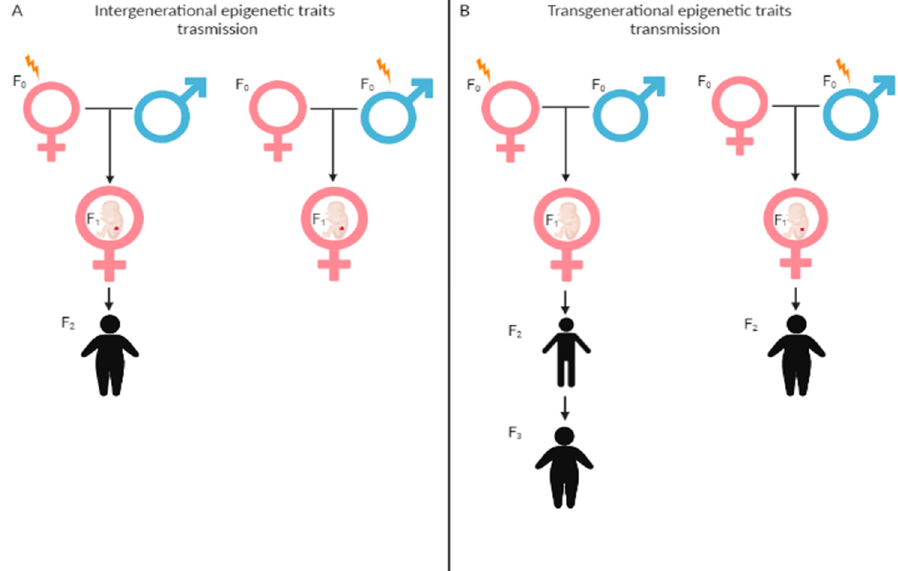
Figure 1. Intergenerational vs. Transgenerational inheritance. ( A ) Intergenerational inheritance occurs when exposure to the maternal womb influences the developing fetus and its germline, leading to an altered phenotype of the child. ( B ) Transgenerational inheritance occurs when exposure to the maternal womb influences the developing fetus and its germline and is transmitted to the F2 or F3